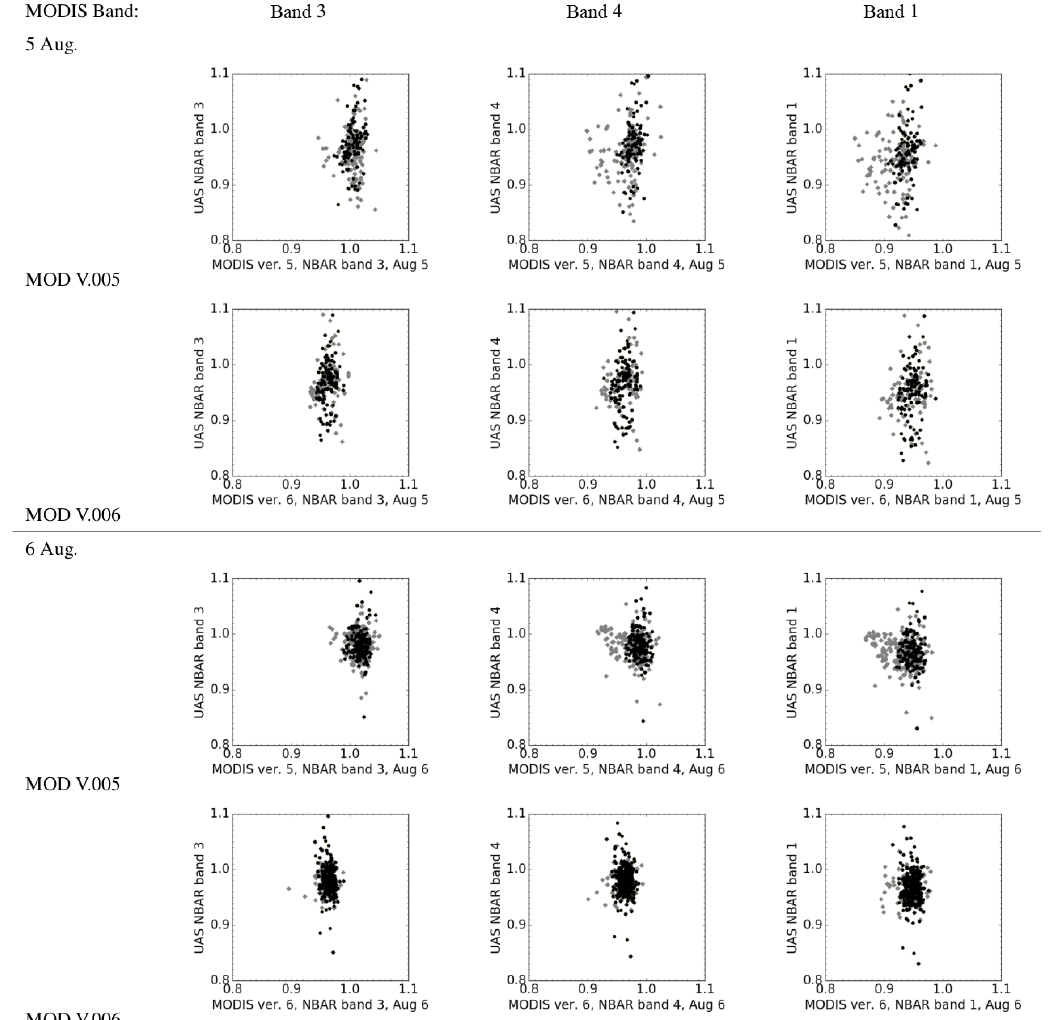
Figure 7. The MODIS (black: high quality; grey: low quality) versus UAS NBAR for bands 3, 4, and 1. Left column is data for band 3, middle column is data for band 4, and right column is data for band 1. Rows 1 and 3 are MODIS version 5, and rows 2 and 4 are MODIS